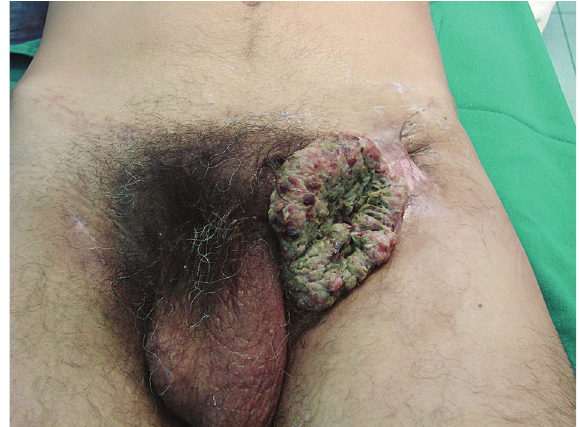
Figure 1 – Patient with large ulcerated metastatic lesion in the inguinal